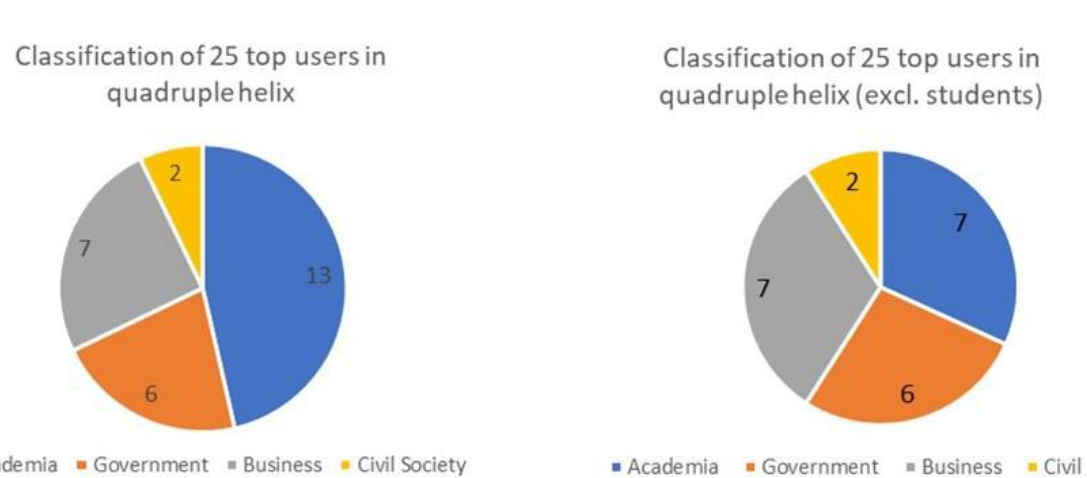
Figure 5. Classification of 25 top users in quadruple helix, with two people having a double function “academia” and